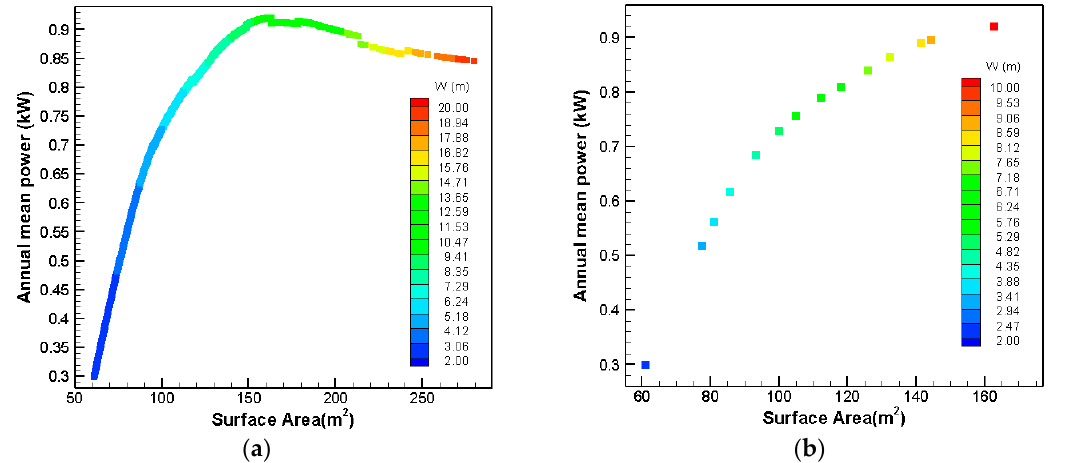
Figure 11. Optimization results of the parallelepipedic hull shape for width parameter: ( a ) all results; and ( b ) the Pareto front.